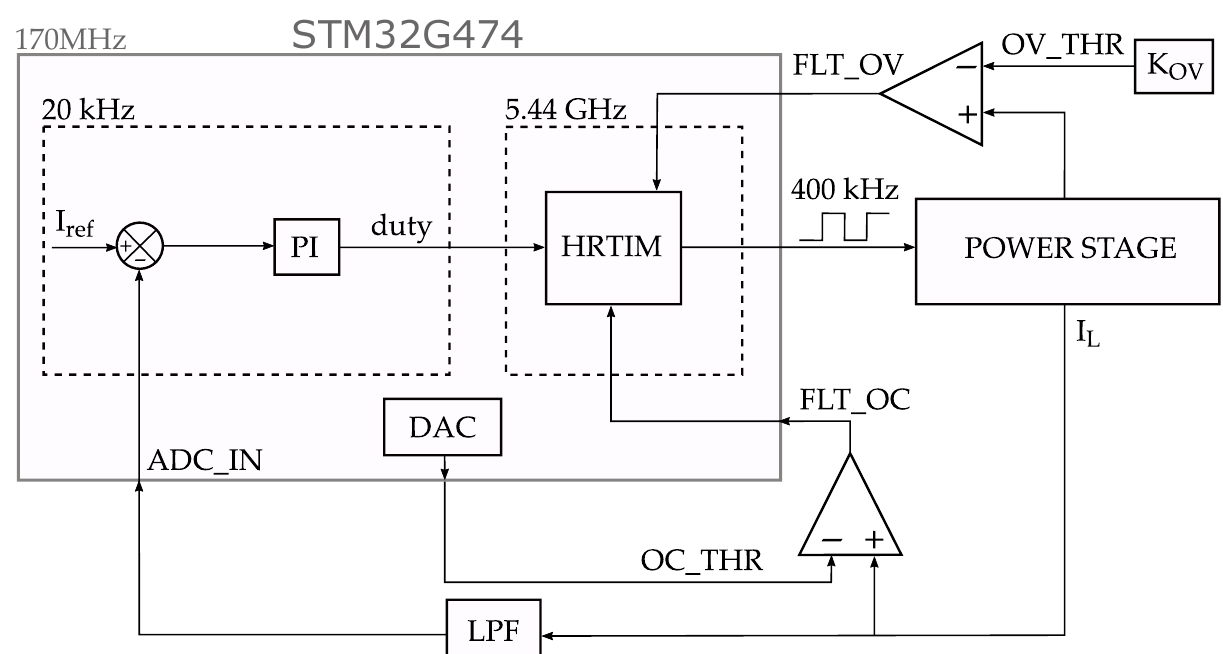
Figure 9. Single-phase controller block diagram with fault detection